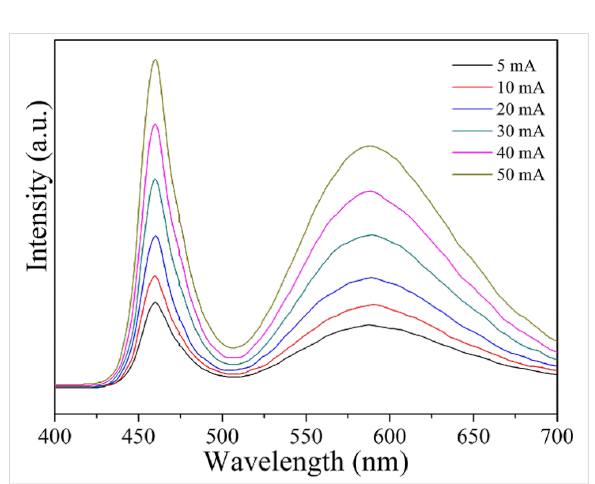
Figure 7: Electroluminescence spectra of a WLED with Tb 2.81 Ce 0.04 Gd 0.15 Al 5 O 12 phsphor under different